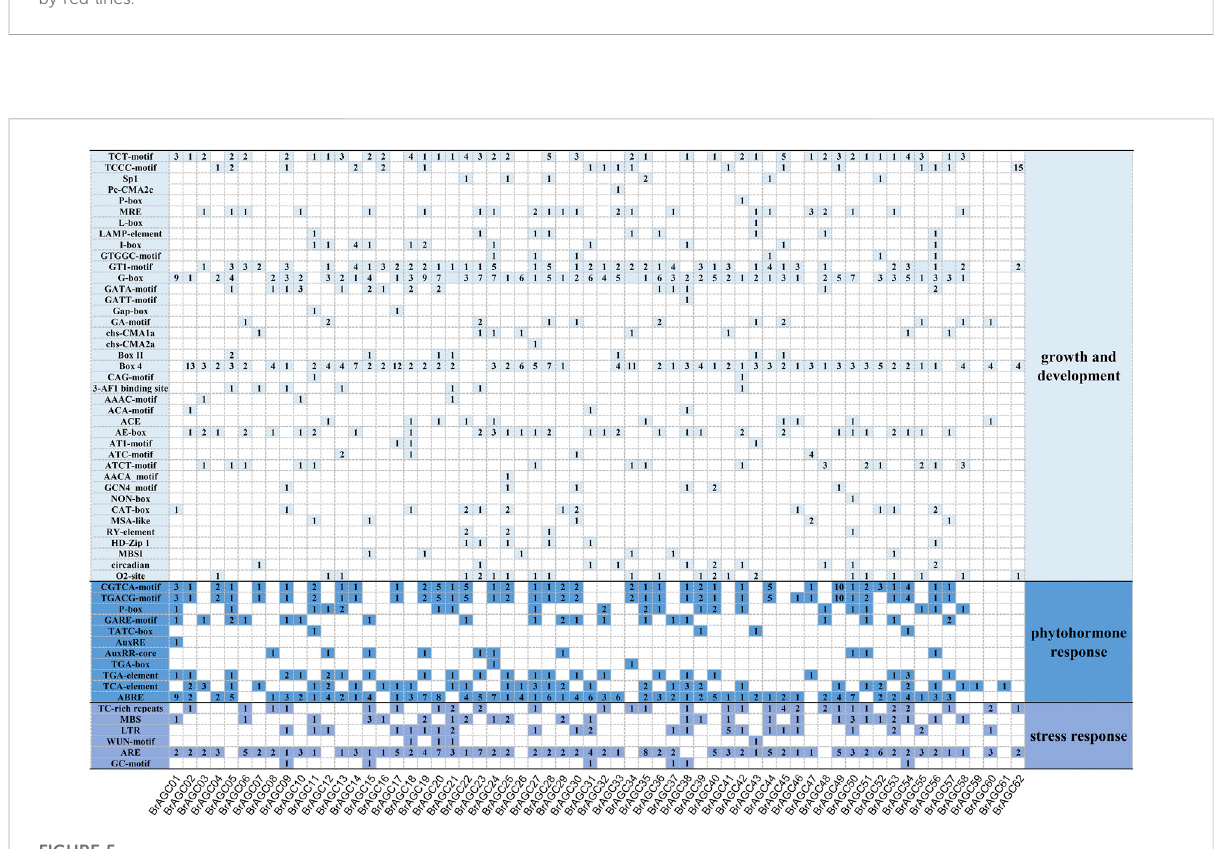
FIGURE 4 Collinearity analysis of B. rapa , A.thaliana , and O. sativa AGC genes. Homologousgenepairs ofAGC protein kinasesbetweenspeciesare linked by red